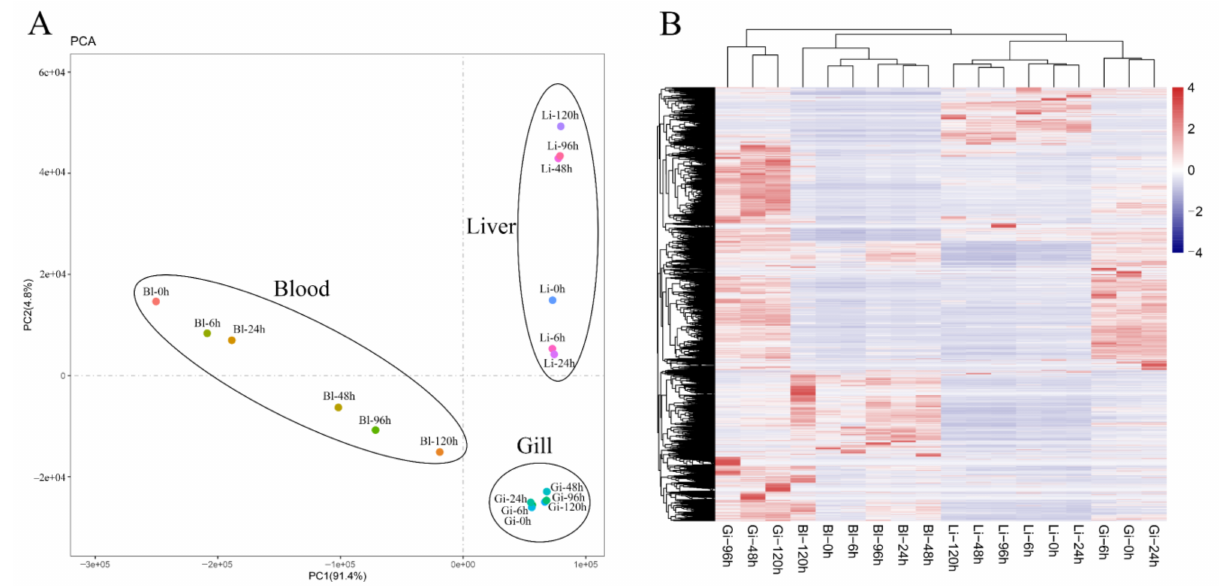
Figure 1. Relationship analysis between samples of different tissues under hypoxia and reoxygenation conditions in L. crocea . ( A ) Principal component analysis (PCA) of different transcriptome samples; ( B ) Heat maps analysis of all expressed genes in different samples, values in toolbar are log10 FPKM values of expressed